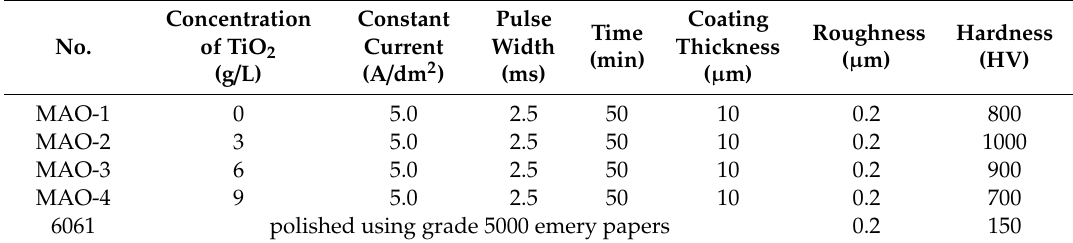
Table 2. The process parameters employed in this study.